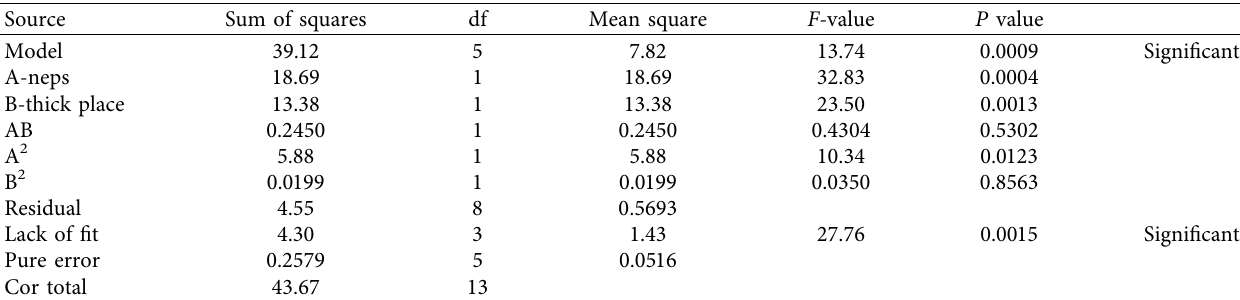
Figure 4: The relations of each imperfection on the air permeability of the fabric. Table 4: Response 1: air permeability by using ANOVA for the quadratic model.